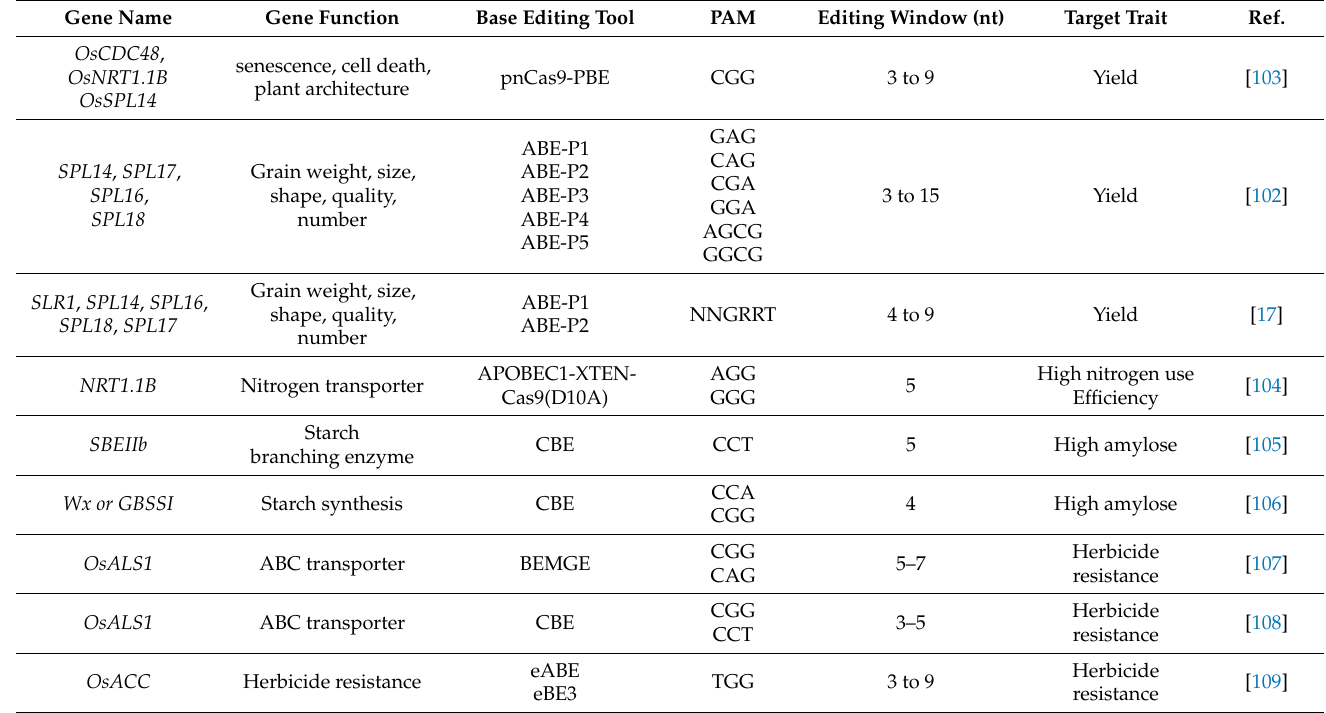
Table 6. Applications of base editing for rice crop